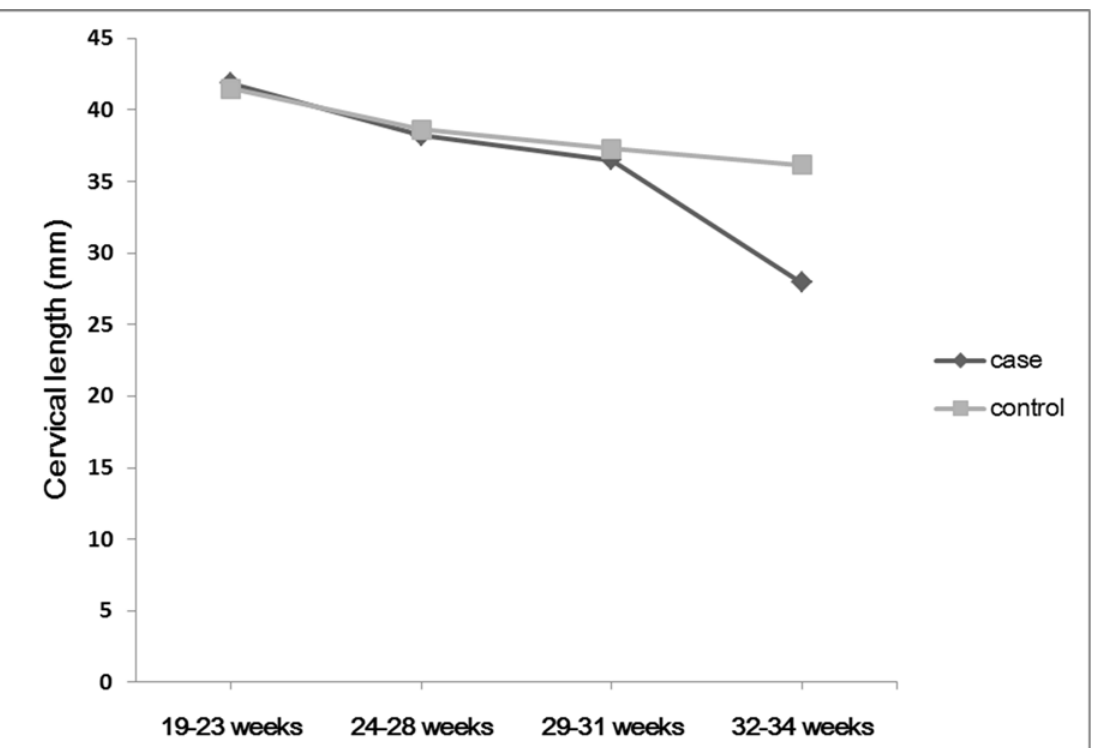
Fig 1. Serial changes in cervical length from 19 to 34 weeks comparing two groups. The black line represents the cervical length of women in the emergent cesarean delivery group, and the gray line represents that of the elective cesarean